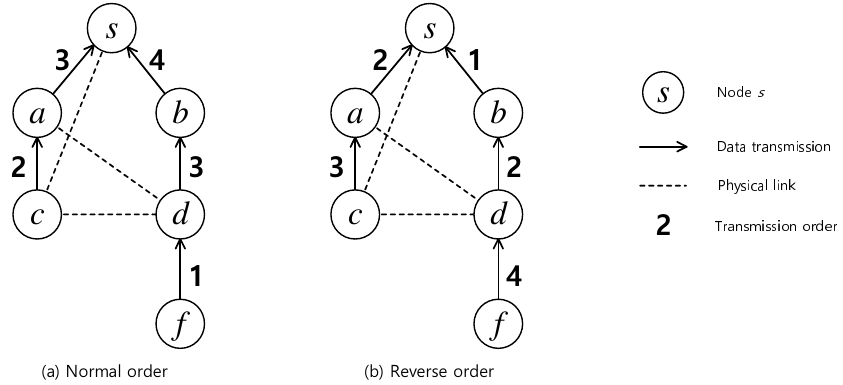
Figure 2. Example of ( a ) a normal order schedule and ( b ) a reverse order